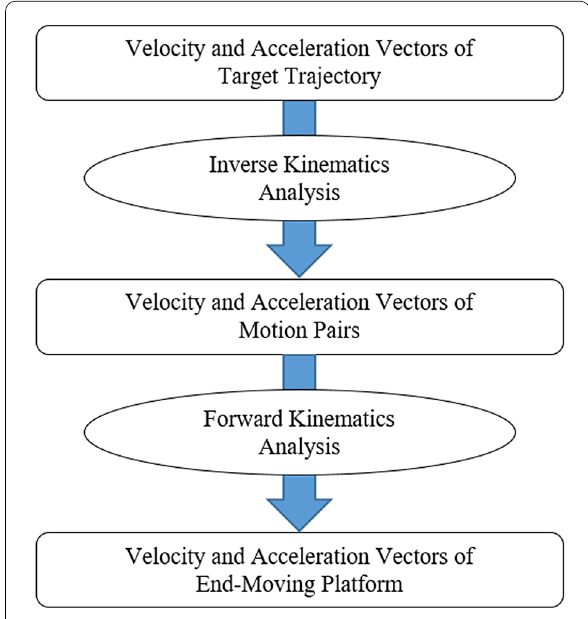
Figure 10 Verification